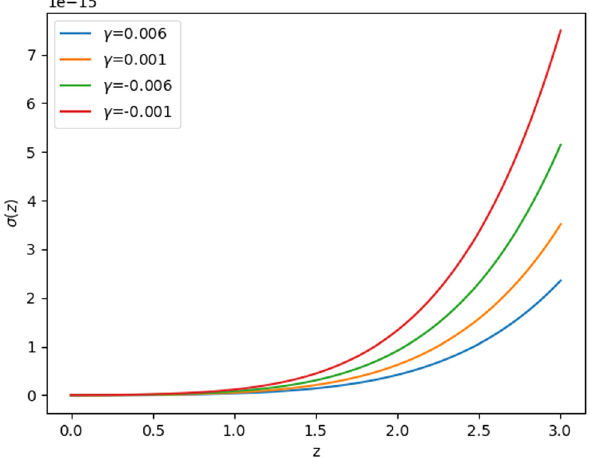
Figure 5: The evolution of the shear parameter in